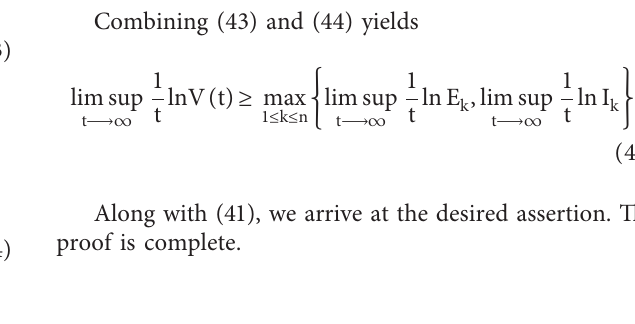
Figure 1: The trajectories with R (a) the trajectory without stochastic perturbation; (b, c) the trajectories with stochastic perturbations where parameters are shown in Example